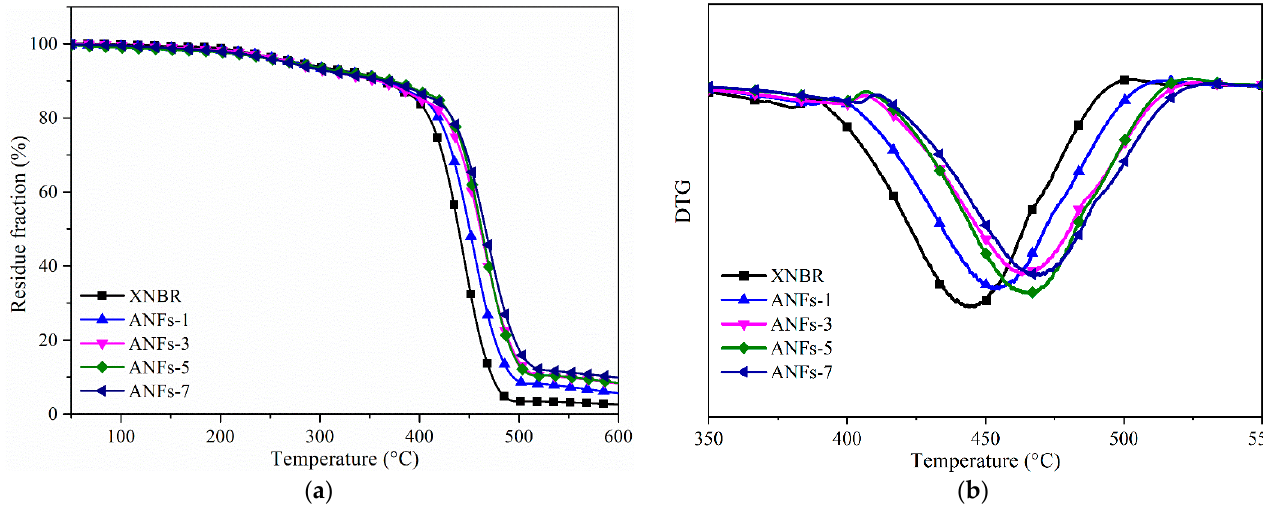
Figure 7. ( a ) TGA curves and ( b ) DTG curves of ANF/XNBR nanocomposites. Table 1. TG parameters for ANF/XNBR nanocomposites.